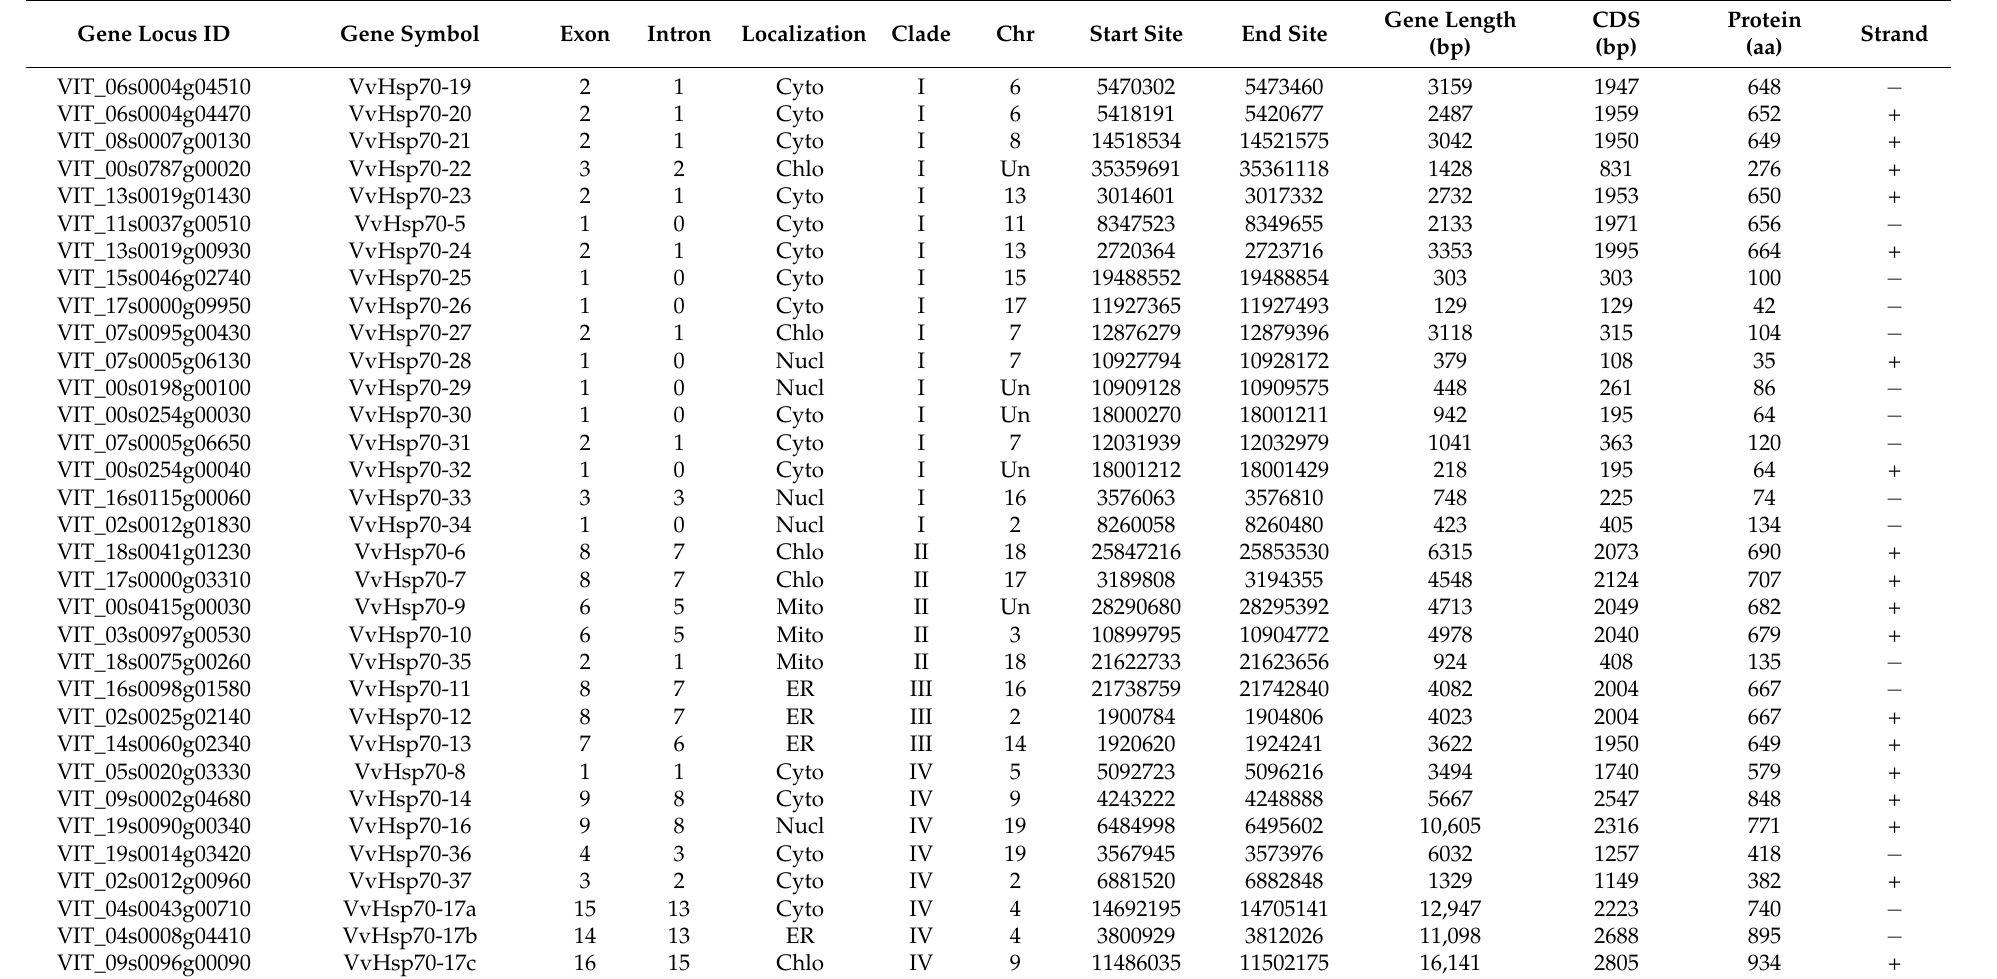
Table 1. Information of VvHsp70 identified in